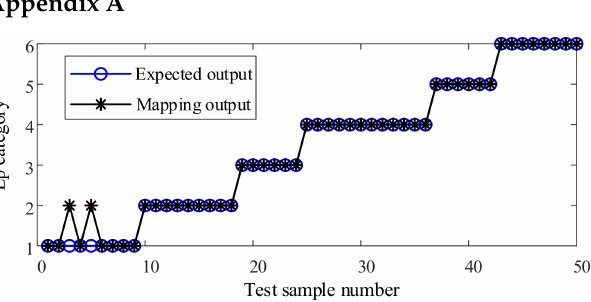
Figure A1. Training results of category ( k ) mapping model between physical parameters and engi- neering parameters.